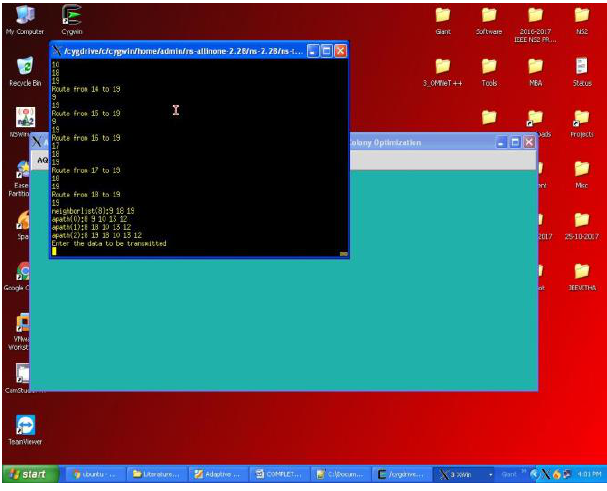
Figure 4: Smart route